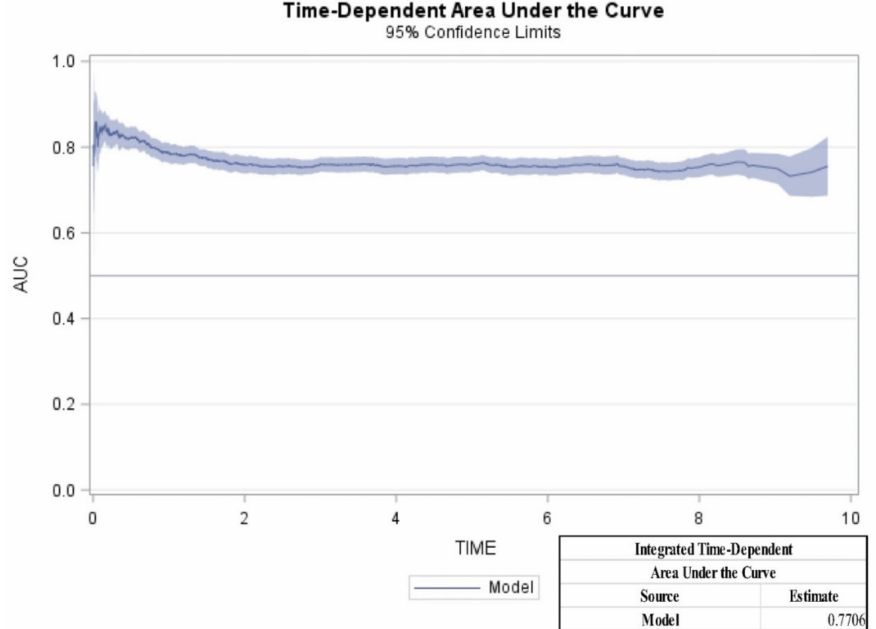
Figure 3. The integrated time-dependent area under receiver operating characteristic (ROC) curve and the 95% confidence limits for the predication